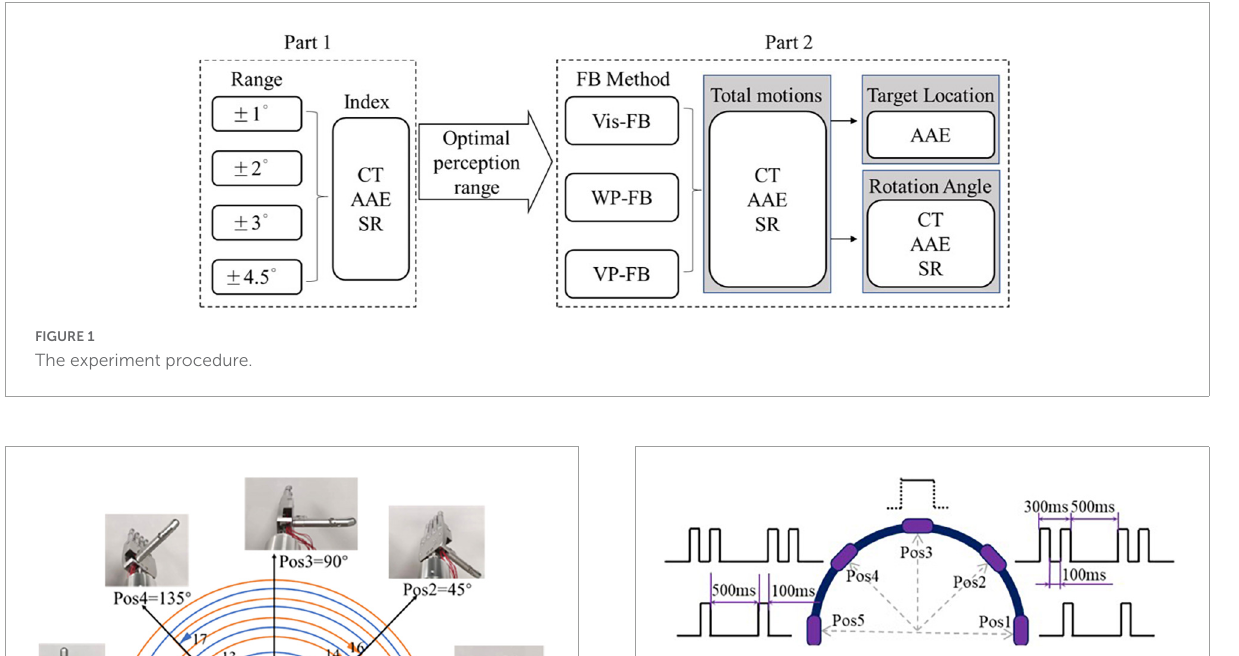
FIGURE3 Vibrotactile feedback